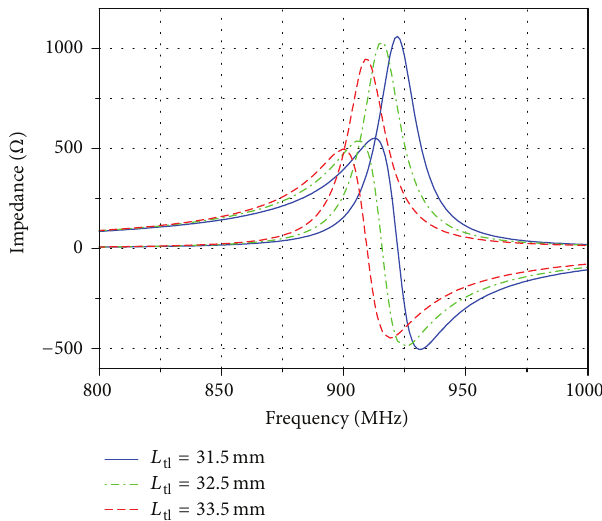
Figure 8: Antenna input impedance for different lengths of the transmission line.